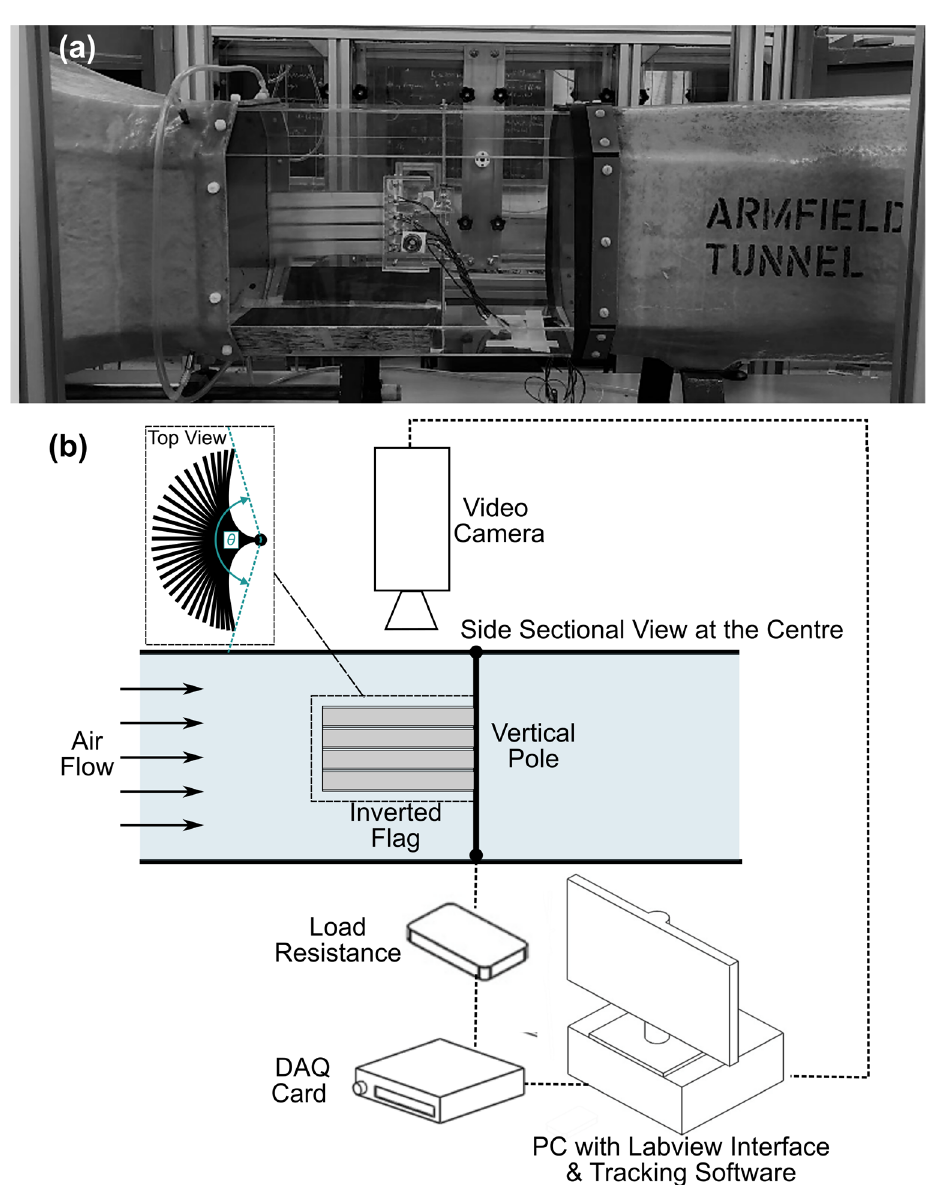
Figure 3. ( a ) Experimental wind tunnel setup, and ( b ) data acquisition schematics (schematic redrawn based on setup demonstration in [20]).